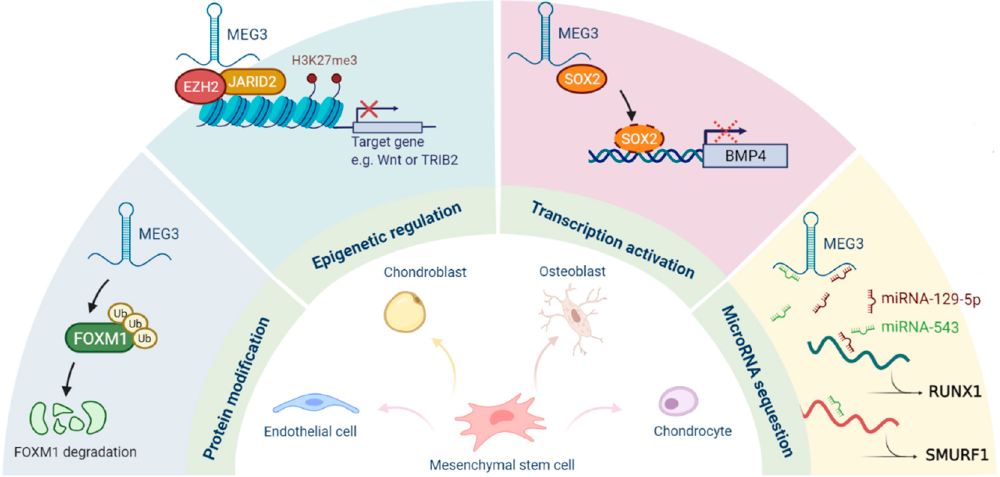
Figure 2. Roles of MEG3 in the regulation of stemness.